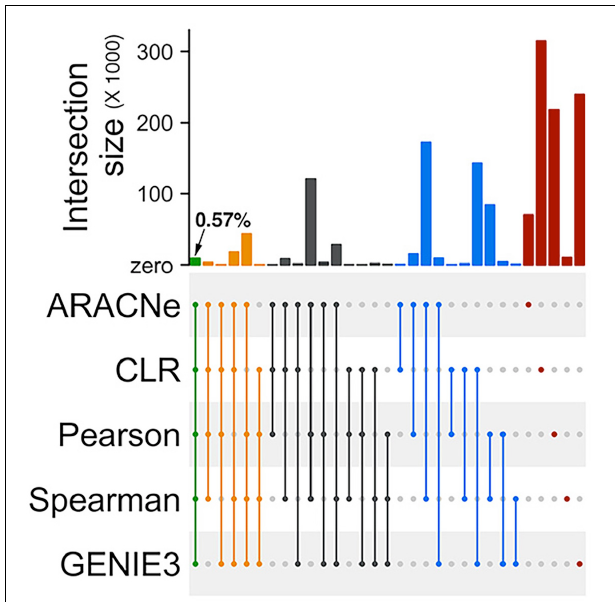
FIGURE 2 | Low overlaps between edges inferred by different network prediction algorithms. An Upset plot showing overlaps between the two mutual-information based algorithms (ARACNe and CLR), two correlation-based algorithms (PCC and SCC), and one decision-tree based algorithm (GENIE3) used for prediction the rice gene regulatory network. ARACNe, Algorithm for Reconstruction of Accurate Cellular Networks; CLR, Context Likelihood of Relatedness; PCC, Pearson’s Correlation Coefficient; SCC, Spearman’s Correlation Coefficient; and GENIE3, Gene Network Inference by an Ensemble of trees. The filled dots in the canter matrix indicate association between the respective sets and the bars on the top show size of the intersection. Green, orange, black, and blue bars indicate intersection size between five, four, three, and two algorithms. Red bars indicate unique edges identified by the corresponding